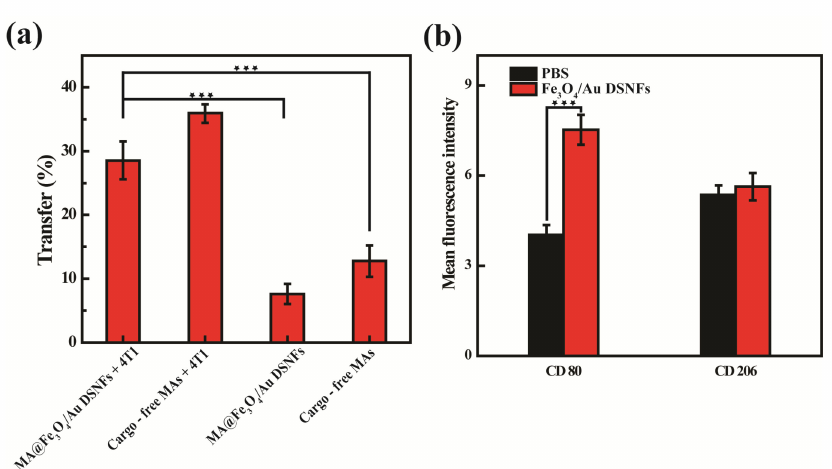
Figure 4. ( a ) Cell migration rates of Raw264.7 cells to 4T1 cells treated with MA@Fe 3 O 4 /Au DSNFs with 4T1 cell-guided, MA with 4T1 cell-guided, MA@Fe 3 O 4 /Au DSNFs without 4T1 cell-guided, and MA without 4T1 cell-guided for 18 h. ( b ) Quantification of CD80 and CD206 expression via flow cytometry for Raw264.7 cells incubating with and without Fe 3 O 4 /Au DSNFs in the in vitro